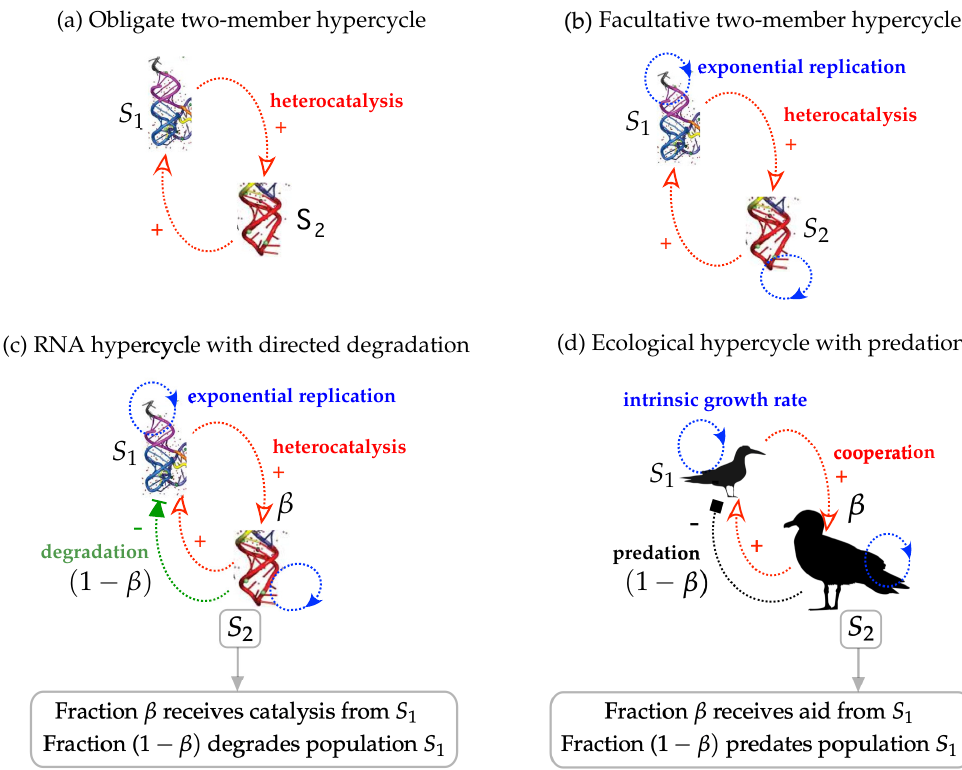
Figure 1. The different hypercycle architectures studied in this article: ( a ) obligate two-species hypercycle with heterocatalysis; ( b ) facultative system with heterocatalysis and autonomous self- replication; ( c ) hypercycle including directed degradation of S 1 by S 2 while still keeping some fractions of the population receiving catalytic aid; ( d ) two-species ecological hypercycle (e.g., wader and seagull) including opportunistic predation (especially on eggs and chicks). Here, S 2 consumes S 1 , while some individuals still receive cooperation from S 1